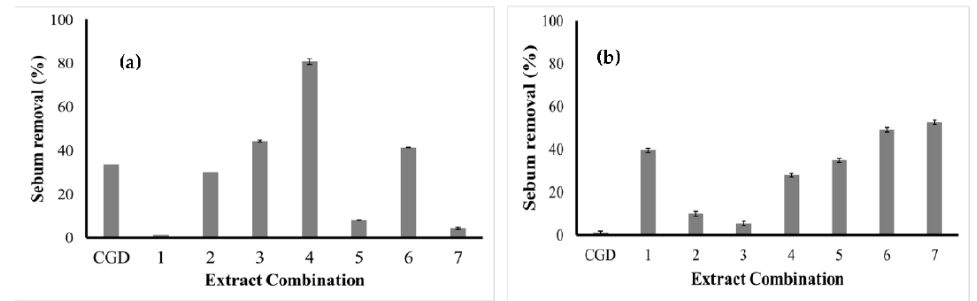
Figure 5. Cleaning potential of plant extracts at concentrations of ( a ) 4% + 10% disodium cocoyl glutamate and ( b ) 10% + 4% disodium cocoyl glutamate. 1. C. Quinoa ; 2. G. Max ; 3. M. Emarginata ; 4. C. Quinoa + G. Max ; 5. C. Quinoa + M. Emarginata ; 6. G. Max + M. Emarginata ; and 7. C. quinoa + G. max + M. emarginata.